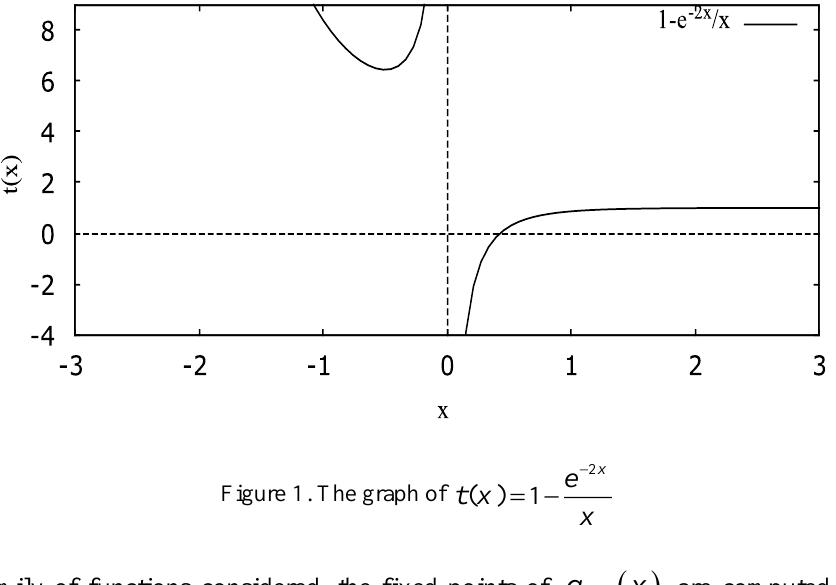
Figure 1. The graph